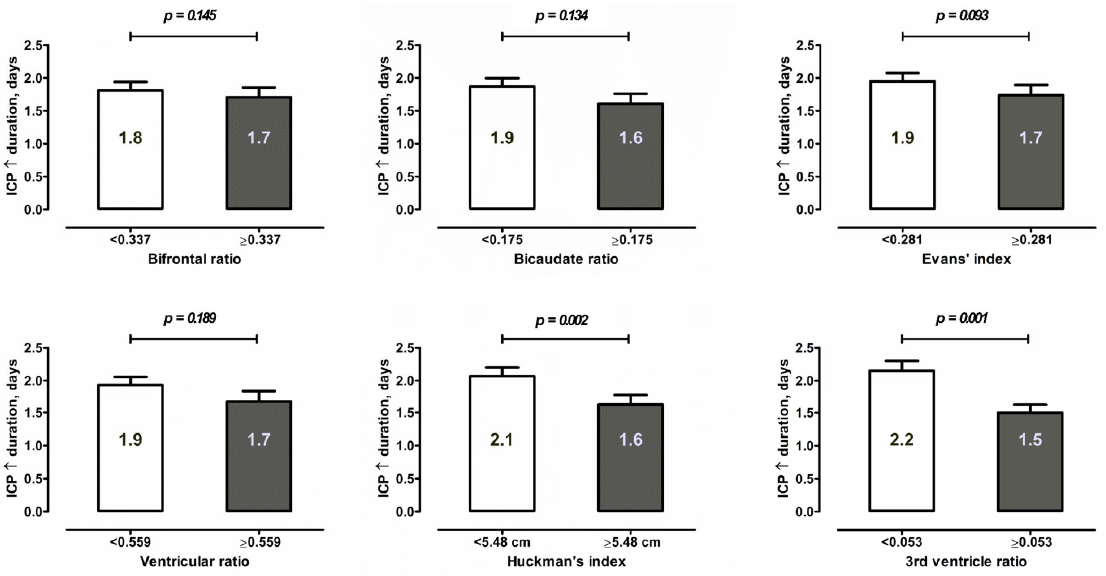
Figure 1. Mean duration of ICP increase after SAH (in days) in different subgroups depending on the values of the ventricular indices. The larger the ventricles are, the shorter the duration of ICP increase > 20 mmHg requiring medical or surgical treatment is.